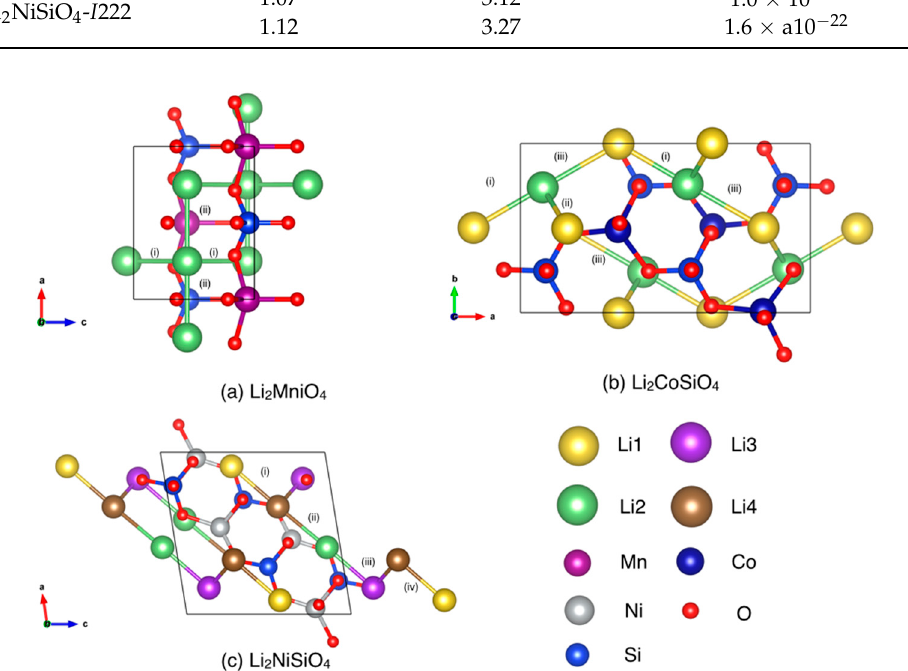
Figure 10. Li ion migration in different possible pathways (represented as i, ii, etc.) in ( a ) Li 2 MnSiO 4 ( Pmn 2 1 ), ( b ) Li 2 CoSiO 4 ( Pbn 2 1 ), and ( c ) Li 2 NiSiO 4 ( P 2 1 ) used for NEB simulation.